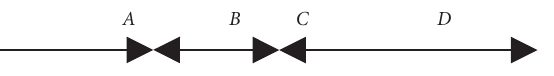
Figure 7: Distance measurement. Table 5: Observed